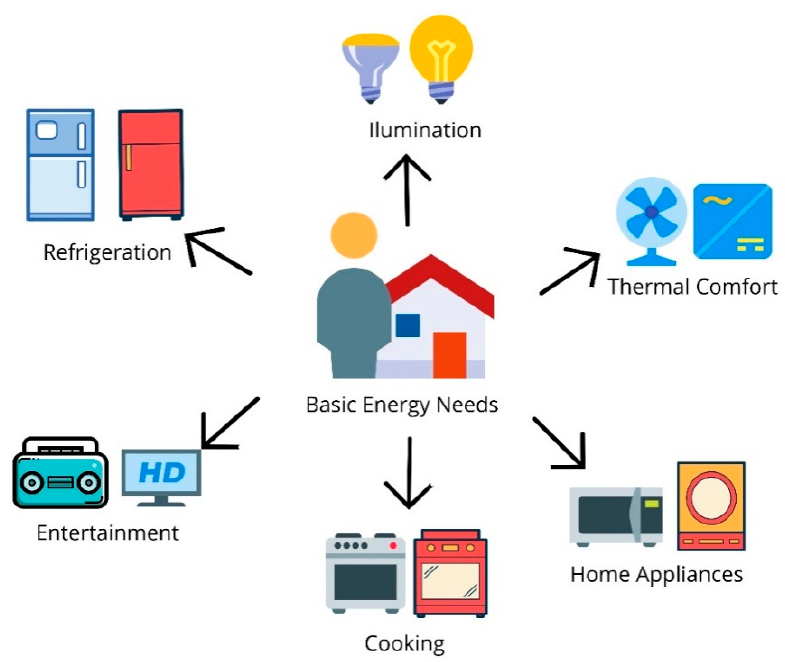
Figure 1. Basic energy needs for Honduran households.